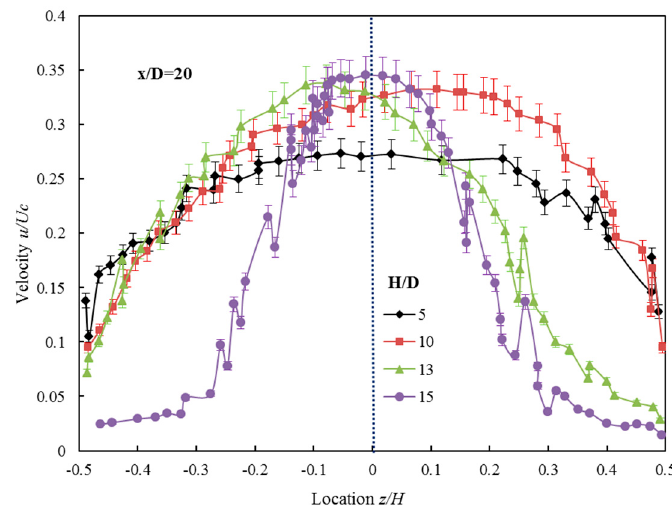
Figure 13. Radial turbulent intensity of the vertical plane ( X - Z ).